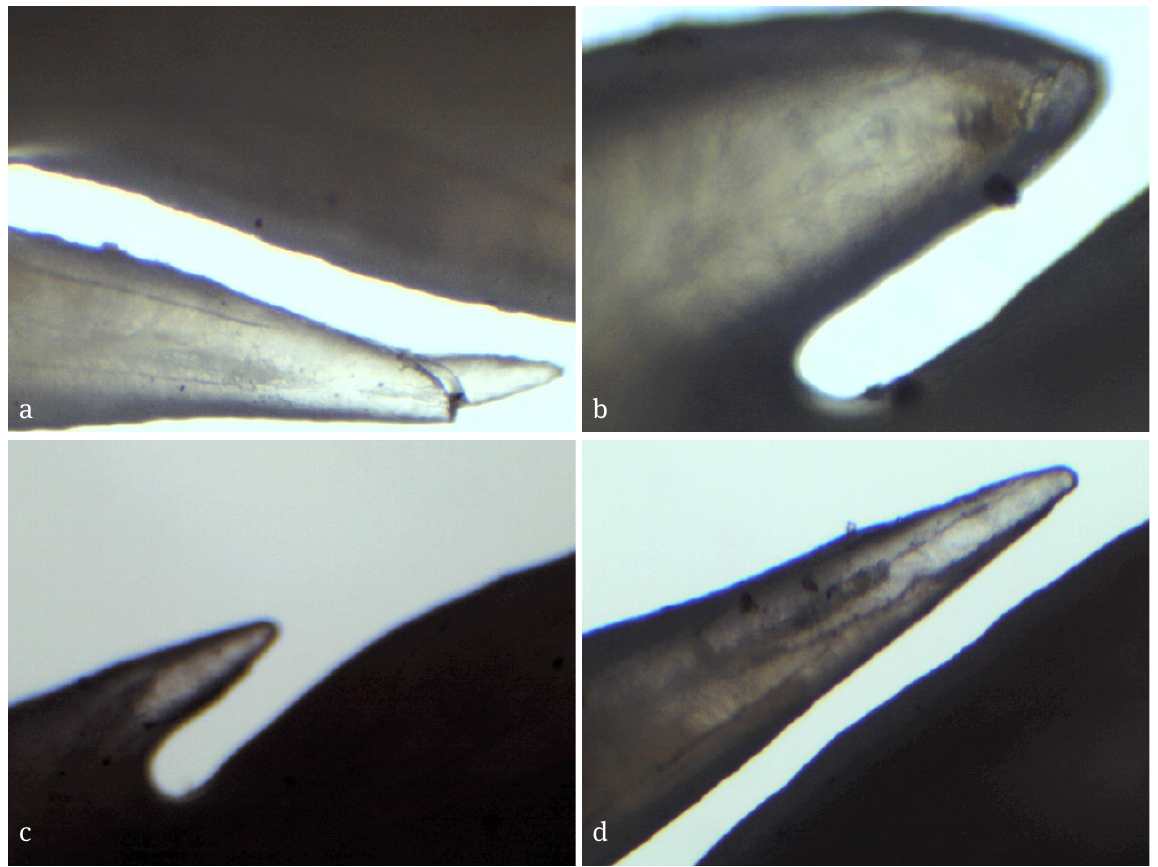
Figure 1 x10 magnification of the serrated edges of a stingray stinger removed from a dog. a. sharp pointed cranial spine with a broken tip, b. blunt caudal spines, c. sharp pointed mid spines, d. sharp pointed caudal